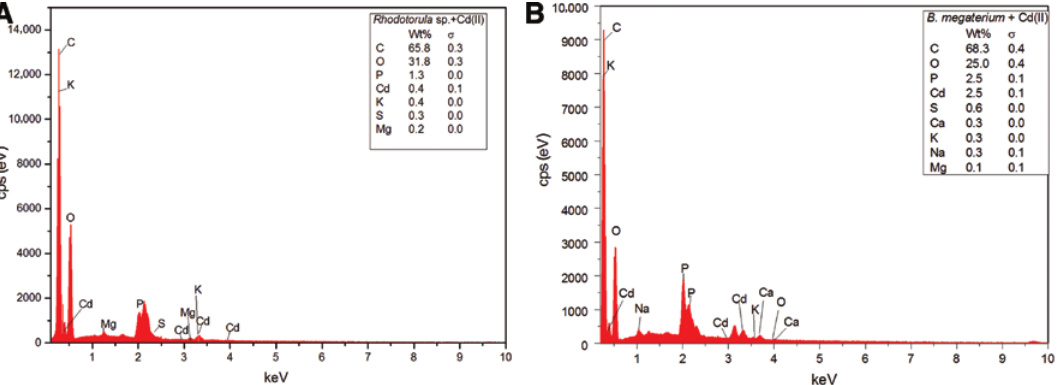
Figure 10: Energy dispersive X-ray microanalysis (EDX) analysis after biosorption of Cd(II) ions by: (A) Rhodotorula sp. and (B) Bacillus megaterium